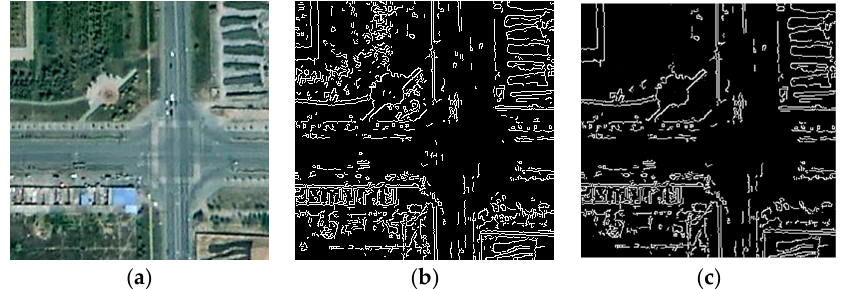
Figure 3. An example of removing the false edge features for training sample: ( a ) The original image, ( b ) preliminary edge features extracted by the Canny operator, ( c ) edge features after removing false edges by artificial process.